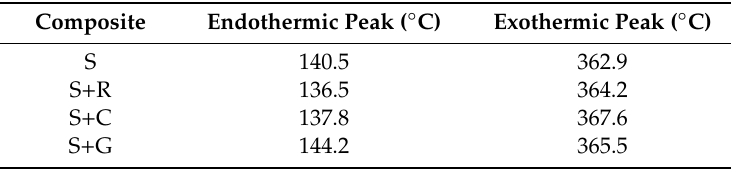
Table 5. DSC data of the composites